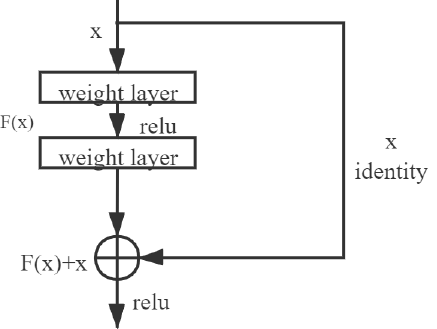
Figure 7. Schematic diagram of residual